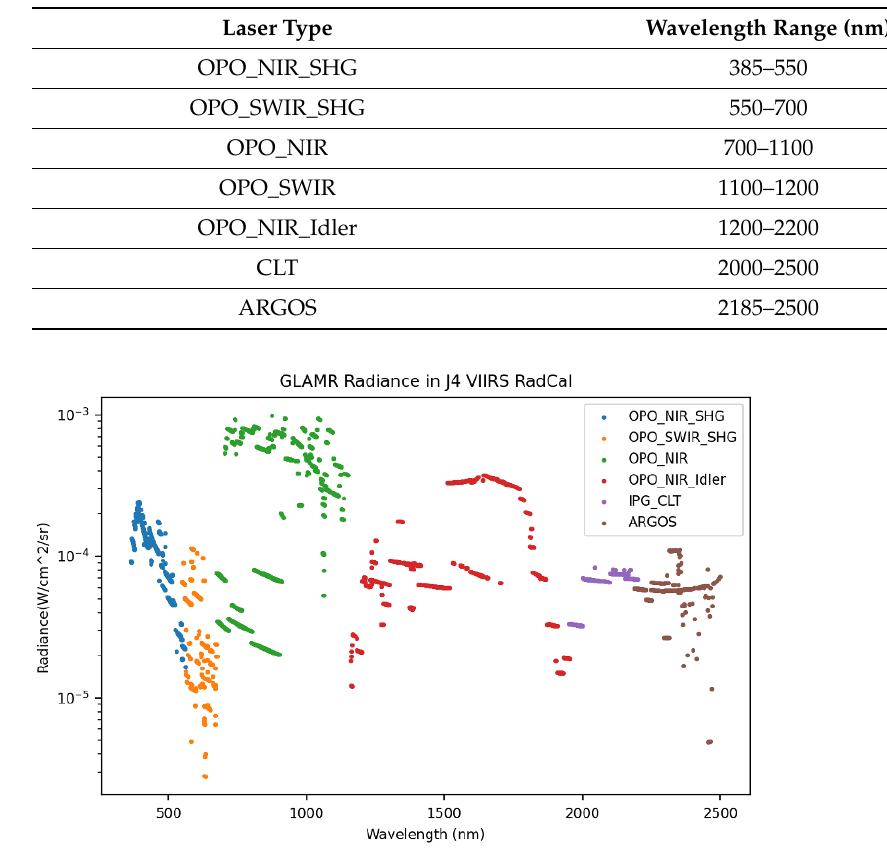
Figure 2. The GLAMR radiance measured during the JPSS-4 VIIRS RadCal. Each data point is the mean radiance at a wavelength